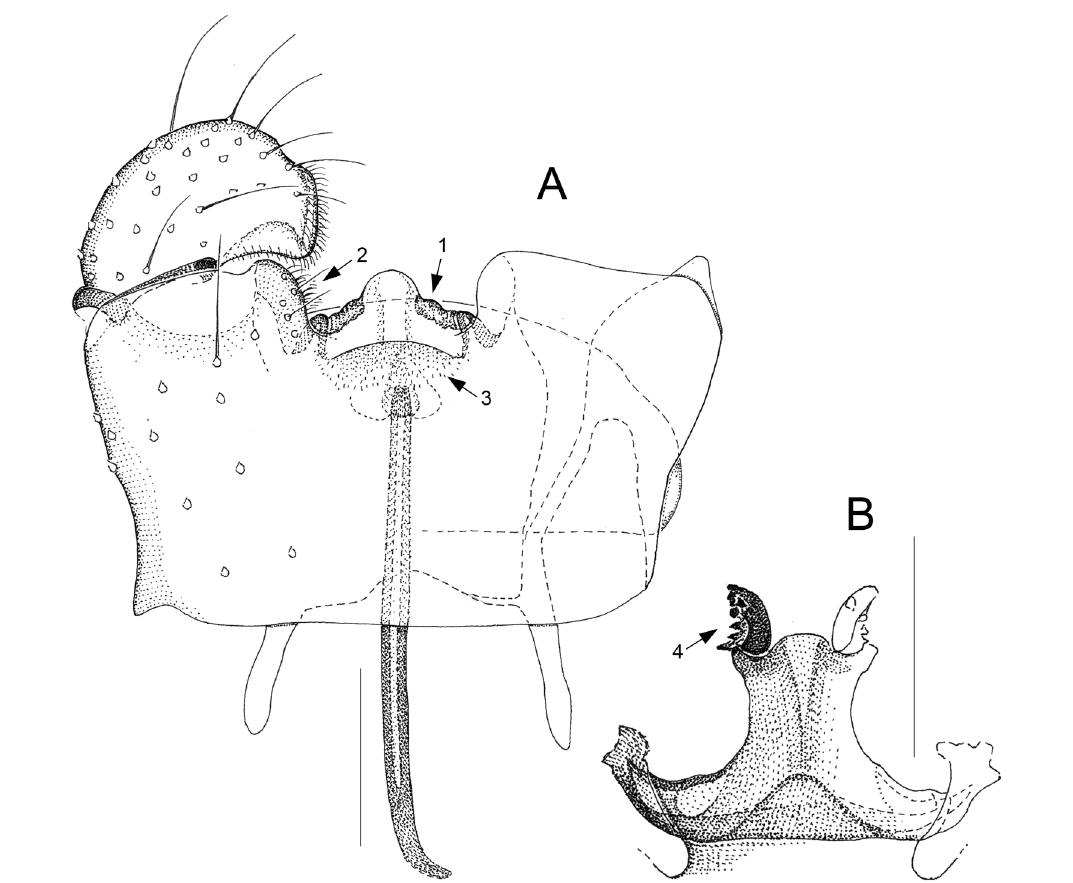
Fig. 7. Glemparon didhami sp. nov., holotype, ♂ (NZAC, no. CEC1422). A . Genitalia, ventral. B . Tegmen, ventral. Scale bars = 0.05 mm. Numbered arrows indicate diagnostic characters (see